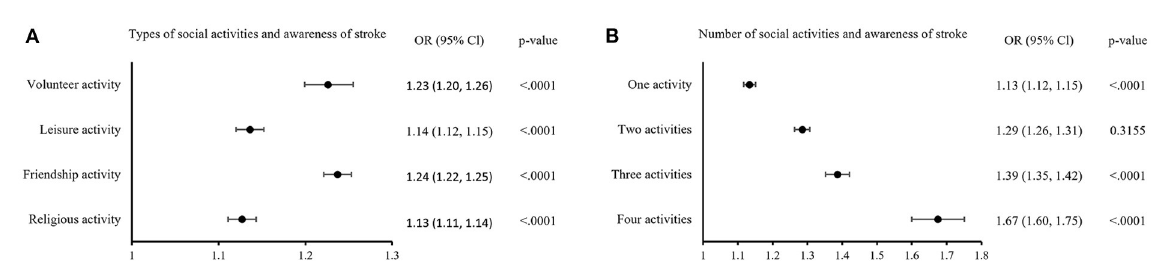
FIGURE1 Subgroup analysis of social activities and awareness of warning symptoms of stroke. (A) Shows the odds of having awareness in individuals who participate in each types of social activities compared to who do not. (B) Shows the odds of having awareness depending on the number of social activities. Odds ratio were adjusted for sex, age, region, marital status, household type, monthly household income, highest level of education, occupation, smoking, drinking, hypertension, diabetes, and examination